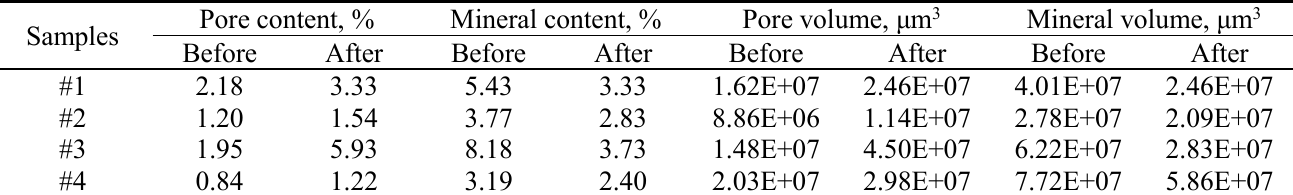
Table 2—Volumes and contents of pores and minerals in coal samples based on X-ray